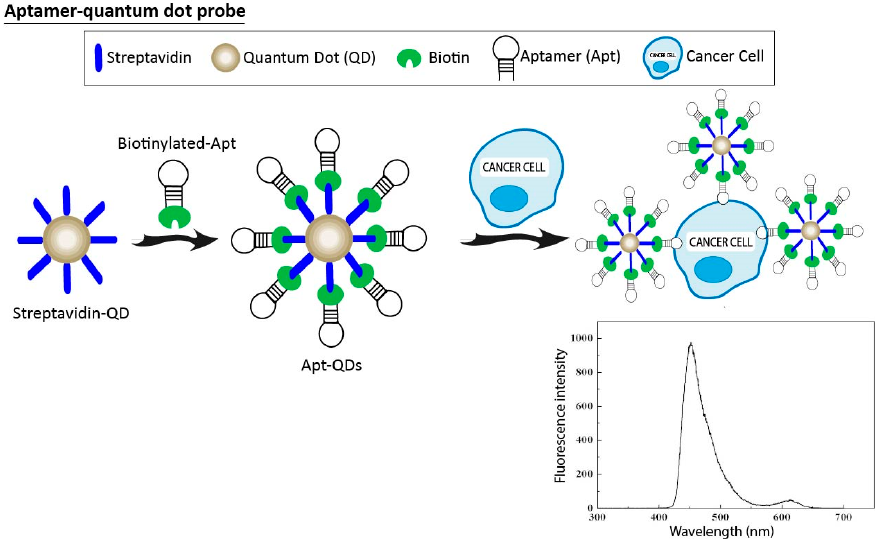
Figure 5. Schematic representation of functionalized aptamer-quantum dot (Apt-QD) probe. A group of biotinylated aptamers (biotinylated-Apt) that target a cancer cell are conjugated with streptavidin-quantum dot (Streptavidin-QD) via biotin-streptavidin-specific interaction. When Apt-QDs recognize the cancer cell, the fluorescence emission spectra of QDs is observed.